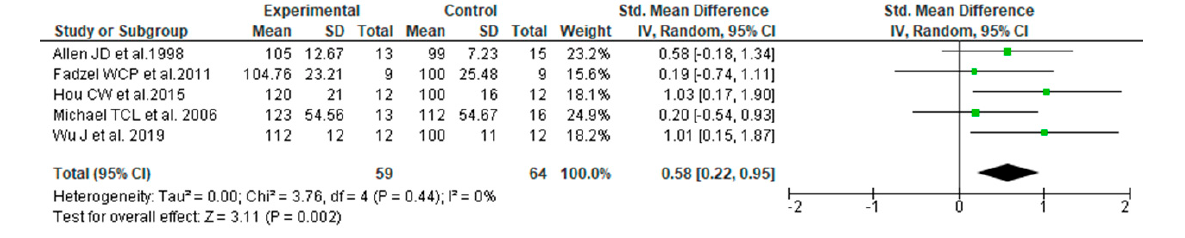
Figure 3. Forest plot for exercise endurance with ingestion Panax genus plants or ginsenoside [12–16].